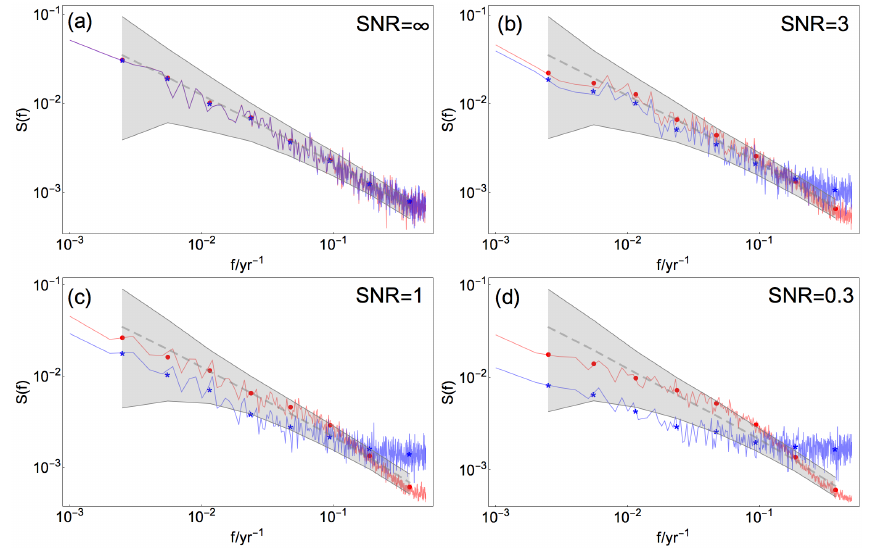
Figure 3. Mean raw and log-binned PSD for pseudo-proxy data (blue curve and asterisks, respectively) and reconstruction at the same site (red curve and dots, respectively) generated from β target = 0.75 and different SNR indicated in (a) – (d) . Colored gray shading and dashed, gray lines indicate 95% confidence range and the ensemble mean, respectively, for a Monte Carlo ensemble of fGn with β = 0.75.